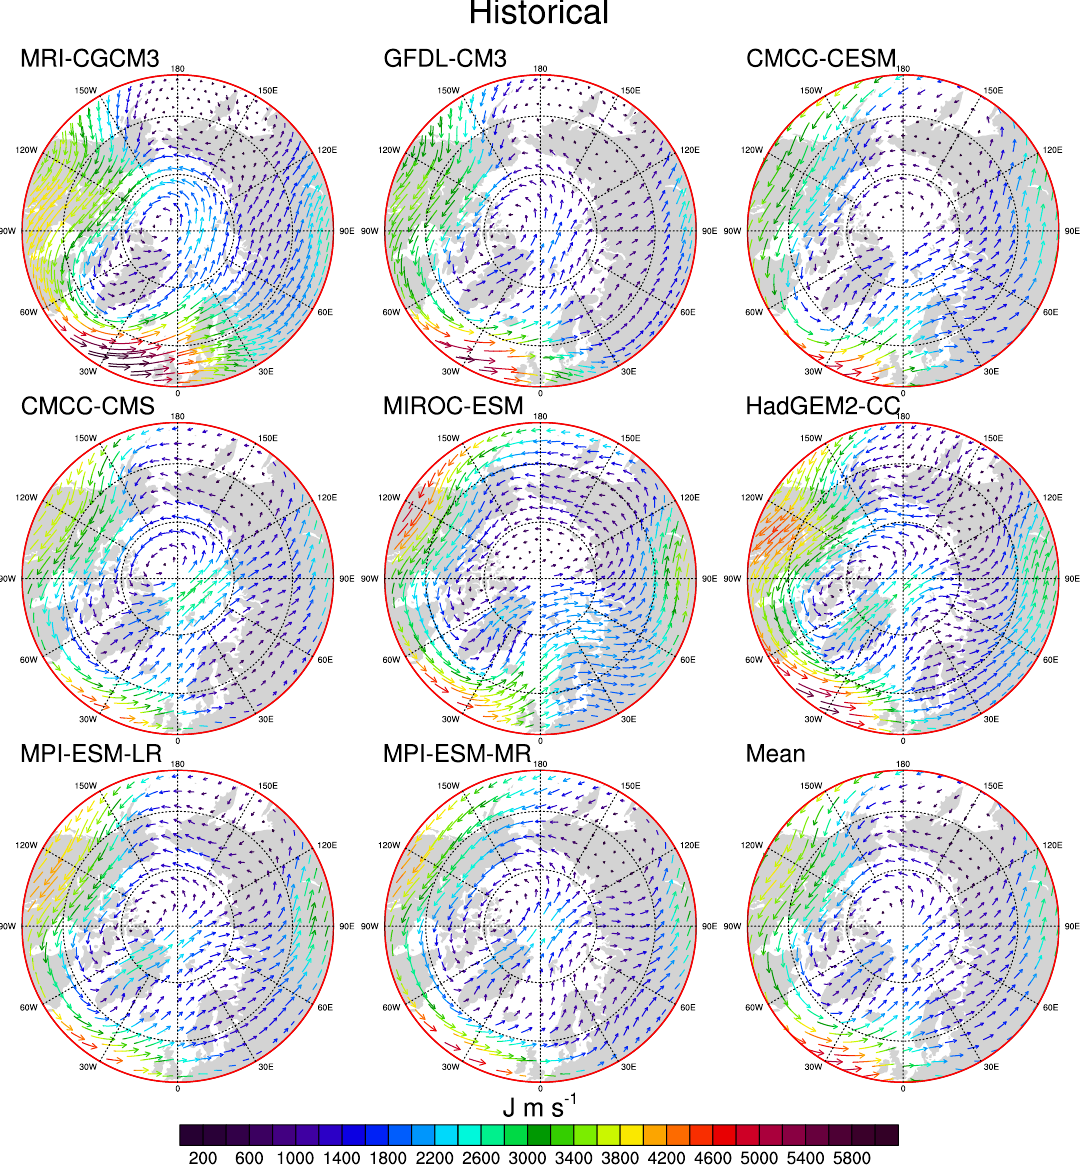
Figure 1. The Atlantic pathway for each of the models listed in Table1, derived based on the CMIP5 historical data for the winters from 1950–1999. Colors and arrows show the amplitudes and directions of the horizontal temperature flux at 500hPa. The multi-model mean of all pathways is shown in the bottom-right